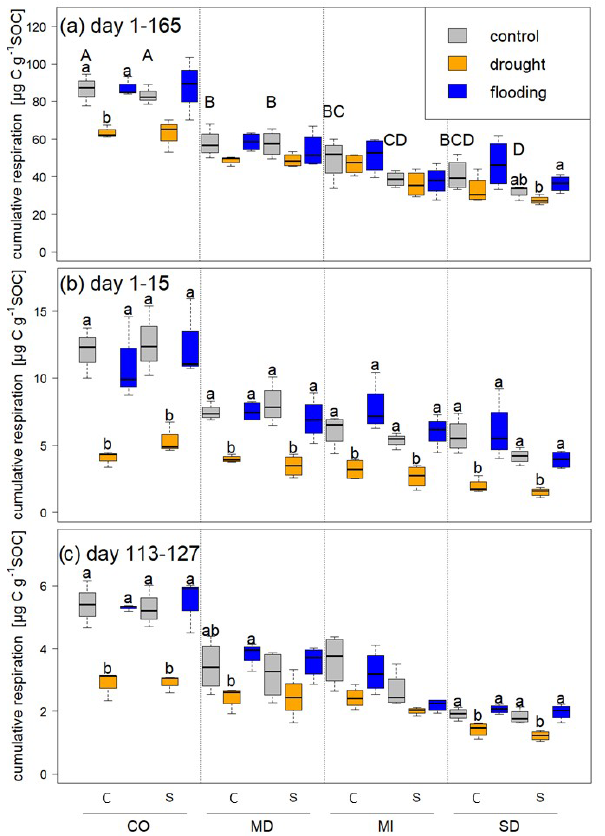
Figure 3. Cumulative respiration calculated per gram of SOC over (a) the whole experimental period, (b) during the first stress pe- riod, and (c) during the fifth stress period. Statistically significant differences among control, drought, and flooding treatments for a given site and rotation complexity (C is a complex rotation and S is a simple rotation) are indicated by letters. Capital letters indicate differences among control treatments of all sites and